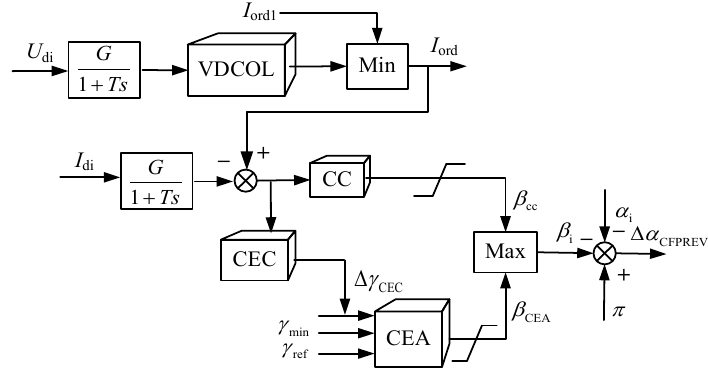
Figure 4. Control block diagram of HVDC inverter side.